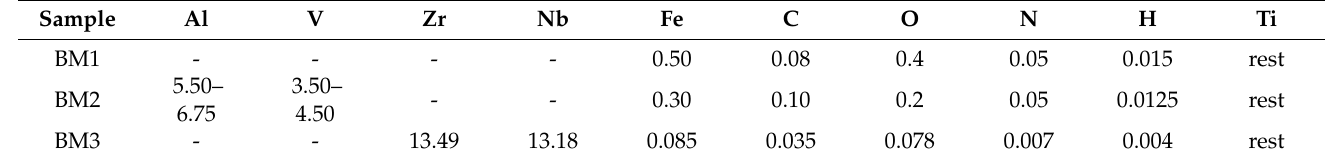
Table 2. The chemical composition of samples (based on the manufacturers’